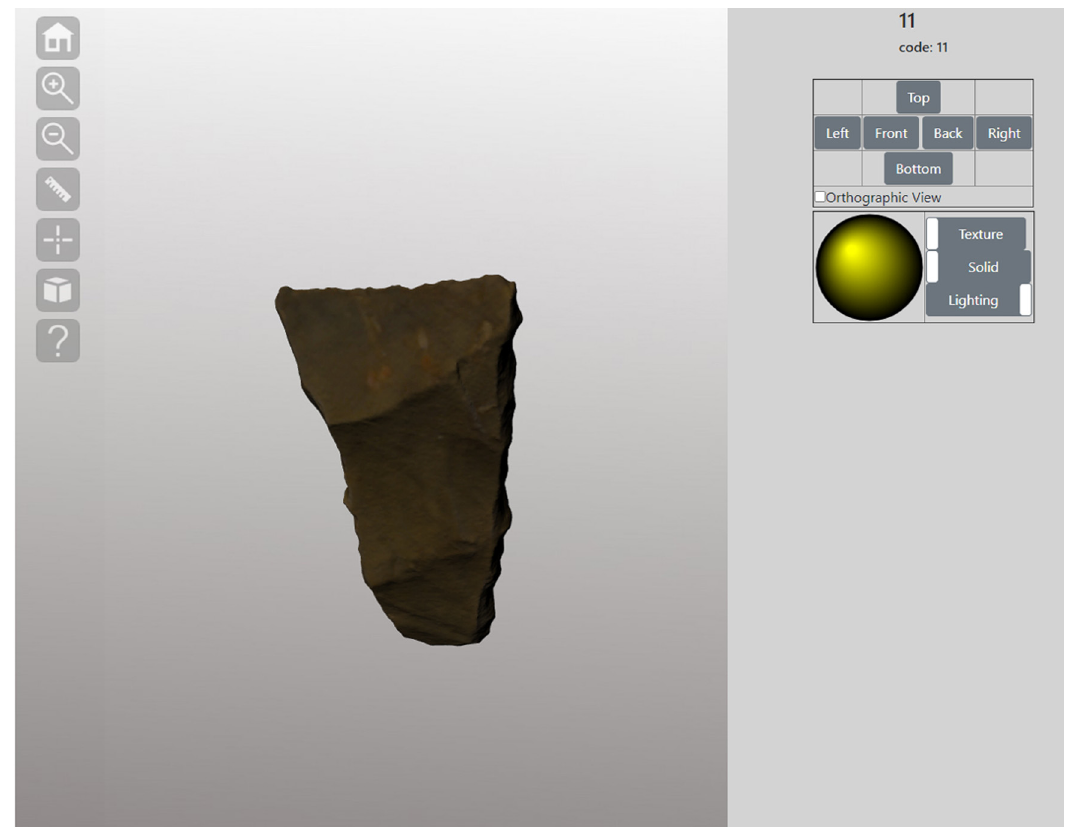
Figure 6: The model of the transverse arrowhead used in the Stone Age exam. Without a scale it may be misunderstood as a fl ake